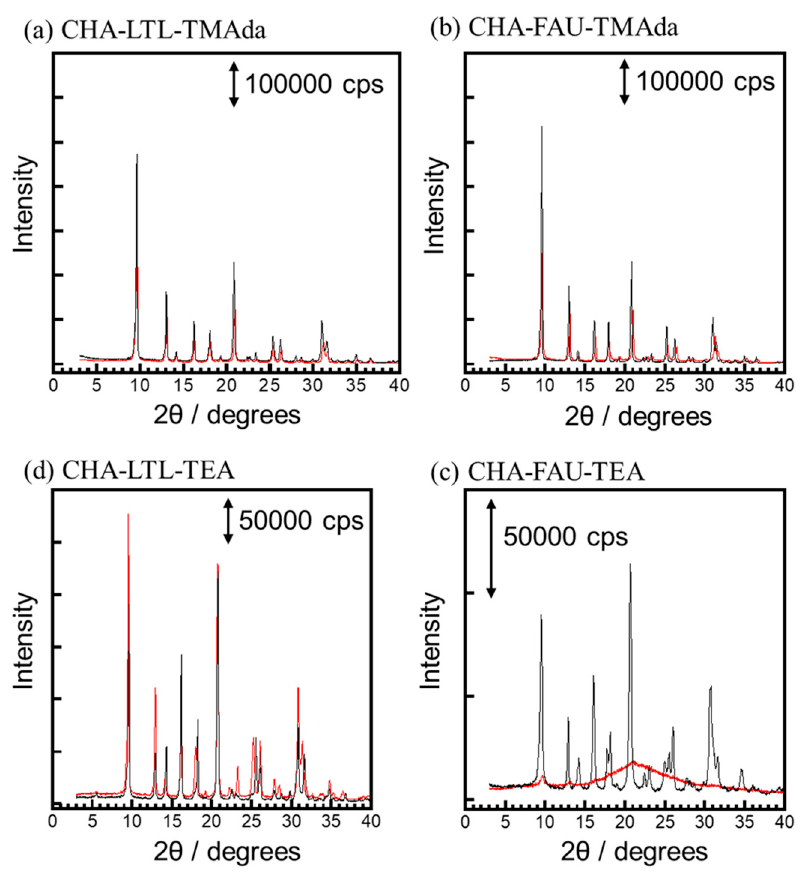
Figure 7. XRD patterns of before (black line) and after (red line) hydrothermal treatment of the samples. ( a ) CHA–LTL–TMAda, ( b ) CHA–FAU–TMAda, ( c ) CHA–LTL–TEA, ( d )